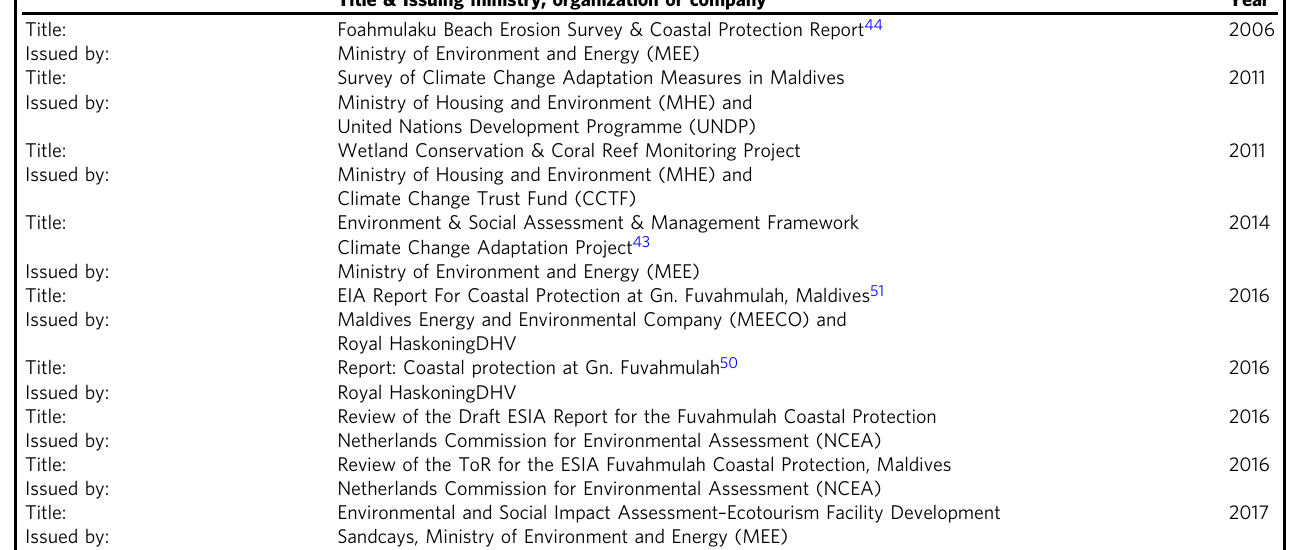
Table 2 List of reports, EIAs and ESIAs on the environment, coastal protection, and adaptation on Fuvahmulah. Laws and policy regulations on coastal risks and sea-level rise in the Maldives are assessed according to the framework of Gussmann and Hinkel 40